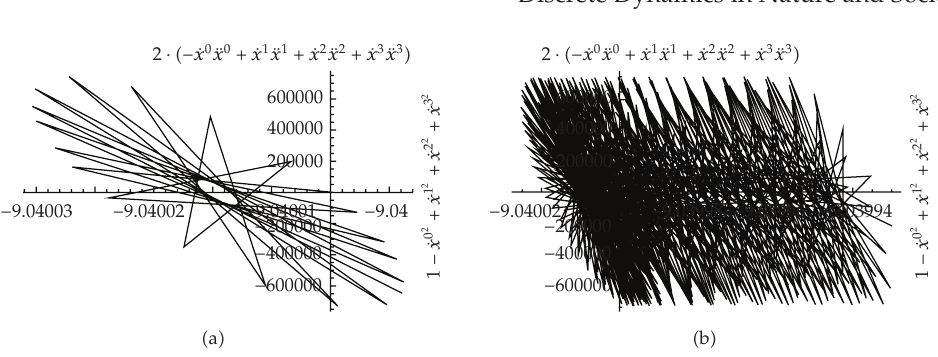
Figure 13: The smaller scale polygonal orbit and its propagation. One can observe the cycling polygonal orbit “filling” the oval frame in a star-like pattern (cid:6) a (cid:7) . There is also a sinusoidal propagation (cid:6) b (cid:7) . Time step: 10 − 10 GeV − 1 . The scale is about 12 times smaller than the one in Figures 12 (cid:6) b (cid:7) –12 (cid:6) d (cid:7) .